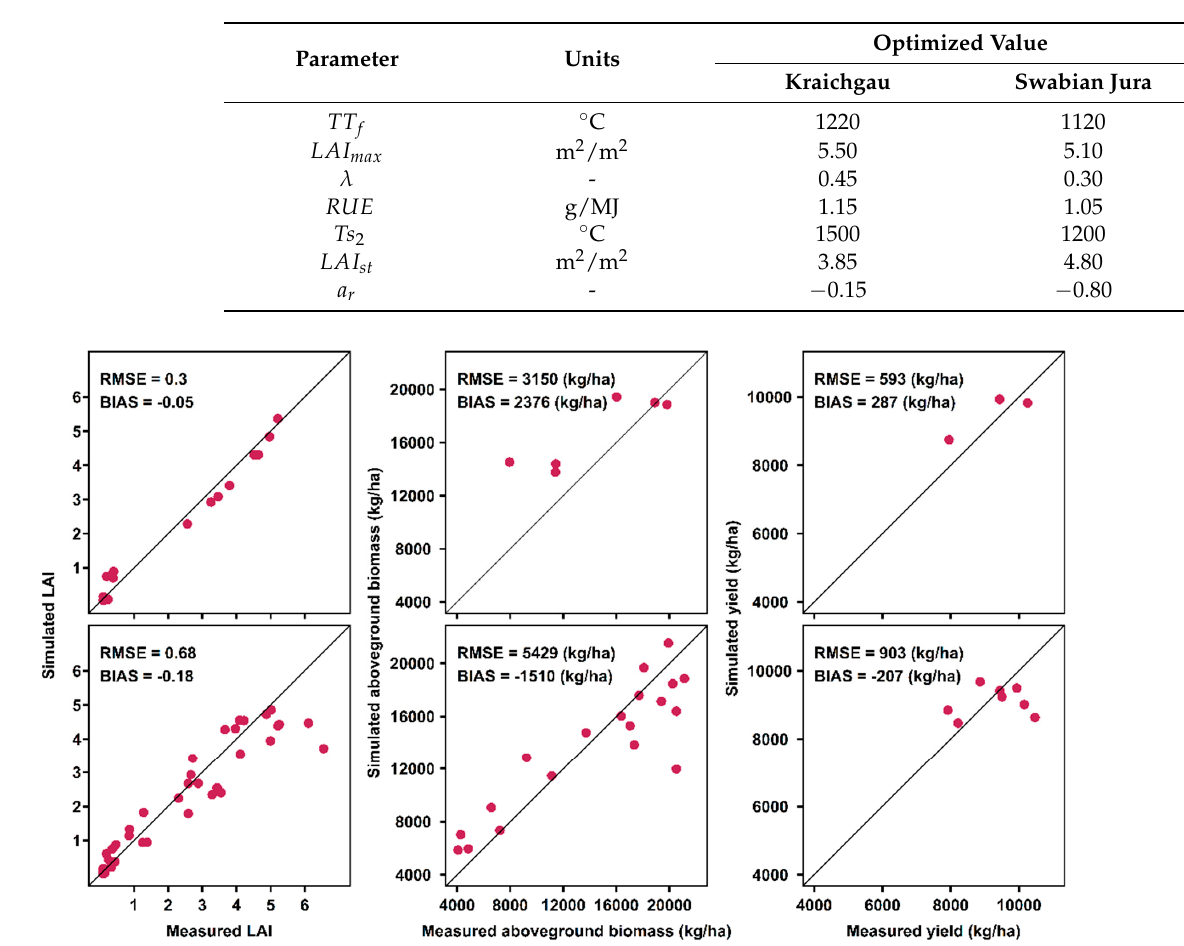
Table A1. Estimated PILOTE and Choudhury model parameters and corresponding posterior uncertainties.